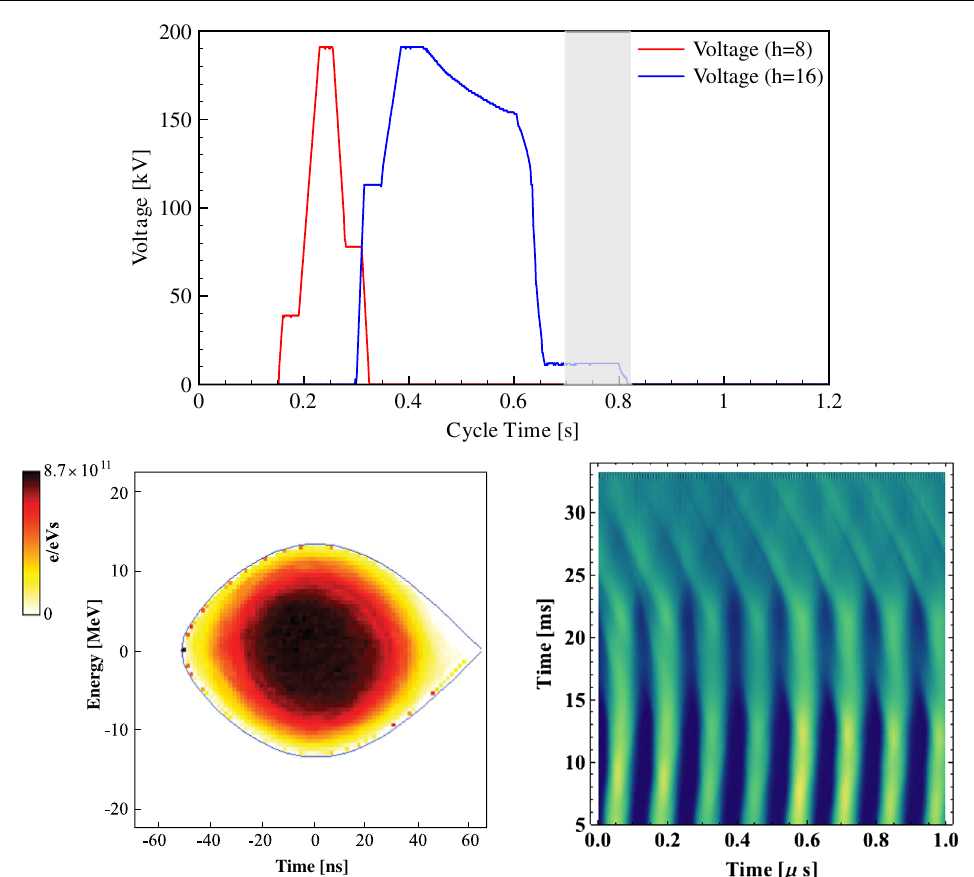
FIG. 5. Evolution of the PS 10 MHz rf cavities voltage used for the generation of the MTE beam (upper plot). At injection, the harmonic number is h ¼ 8 , while during the intermediate flat at 3 : 5 GeV =c each bunch is split longitudinally in two and the harmonic number becomes h ¼ 16 , which is kept constant up to beam extraction. The voltage functions used at the two harmonic numbers are plotted here. The tomographic reconstruction of the longitudinal phase (bottom left) is plotted for the configuration corresponding to the low rf voltage 0.68 s from the beginning of the magnetic cycle. The debunching gymnastic is also shown (bottom right). The horizontal axis represents the bunches along the PS circumference. It is recalled that one turn corresponds to (cid:2) 2 : 1 (cid:5) s and in this plot only half of the PS circumference is displayed. The vertical axis represents the time evolution (the origin of the axis corresponds to 0.8 s from the beginning of the magnetic cycle, when the rf voltage starts to be reduced). The debunching is clearly